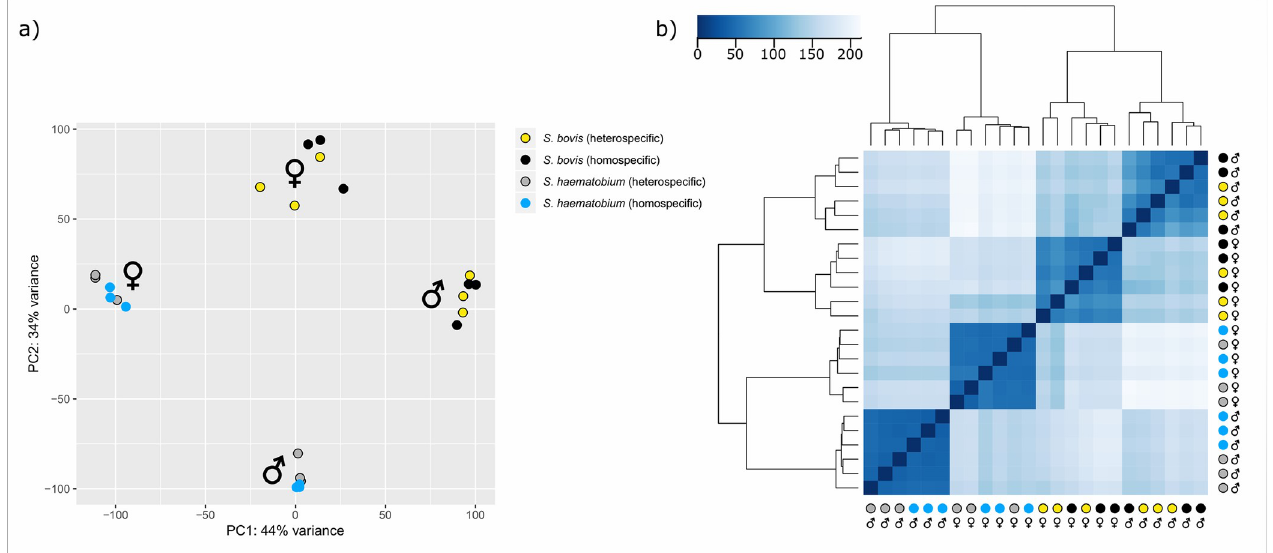
Fig 3. Differential gene expression profiles. a) Principal component plot of the samples and b) Heatmap of the sample-to-sample distances.